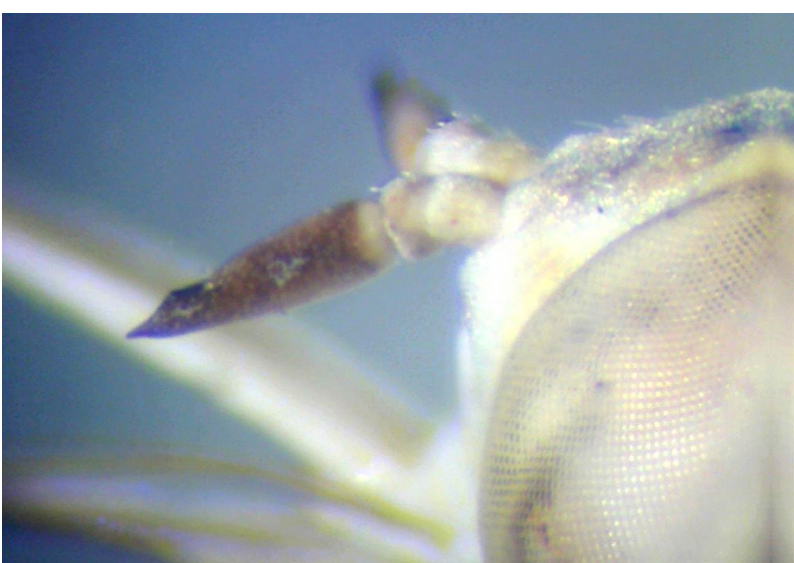
Fig. 27. Parageron orientalis Paramonov, 1929 stat. rev., ♀.